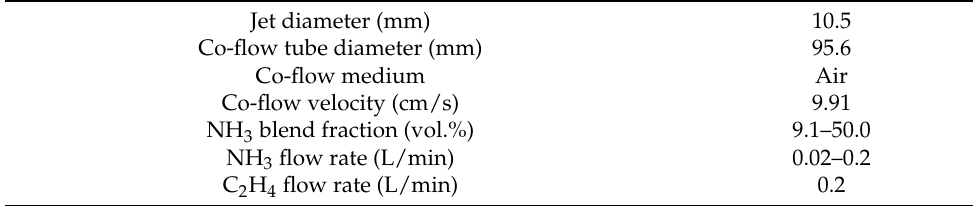
Table 1. Geometry and operating conditions of the burner